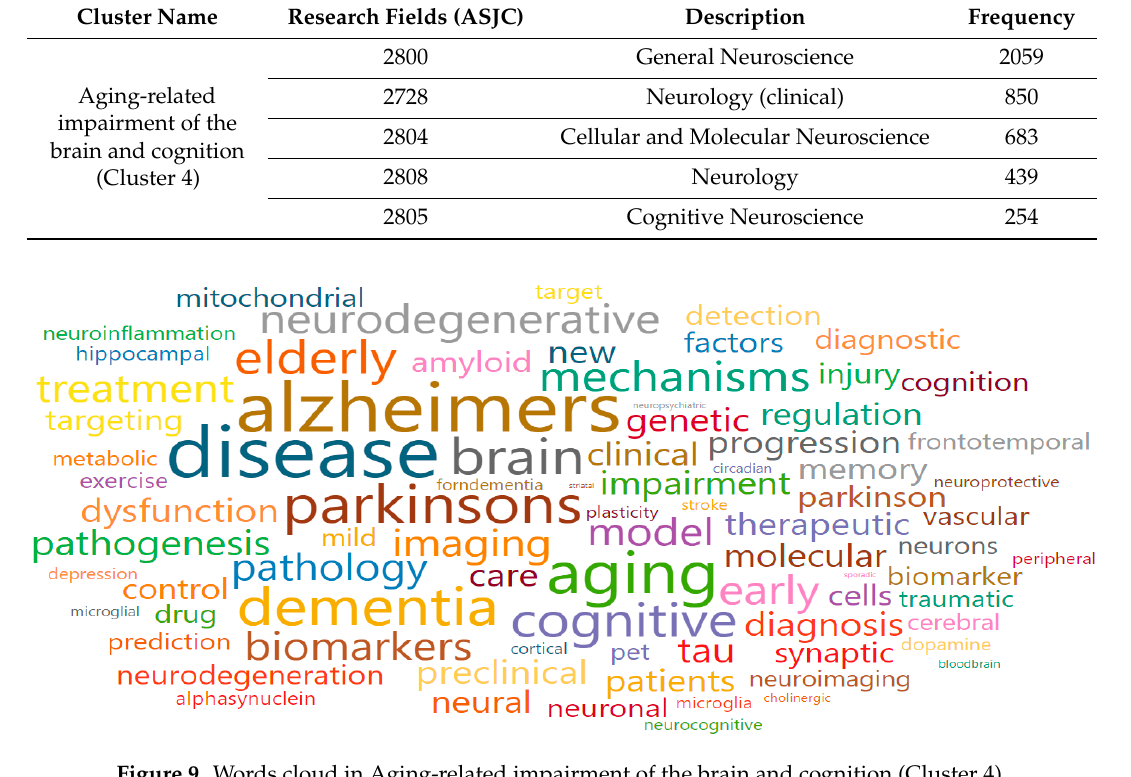
Figure 9. Words cloud in Aging-related impairment of the brain and cognition (Cluster 4).